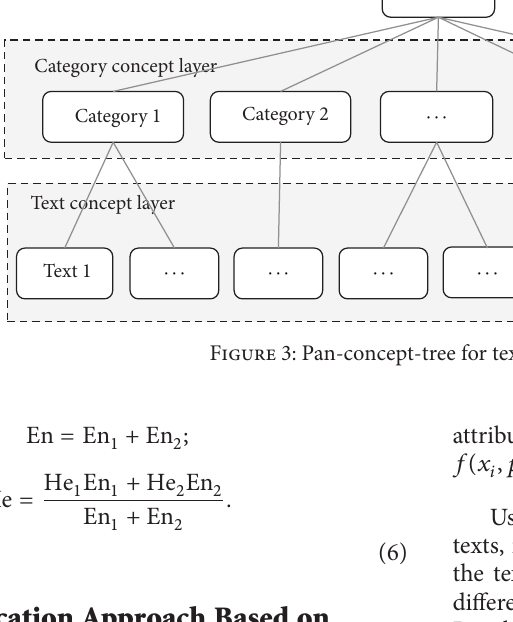
Algorithm 4. The conversion algorithm for text